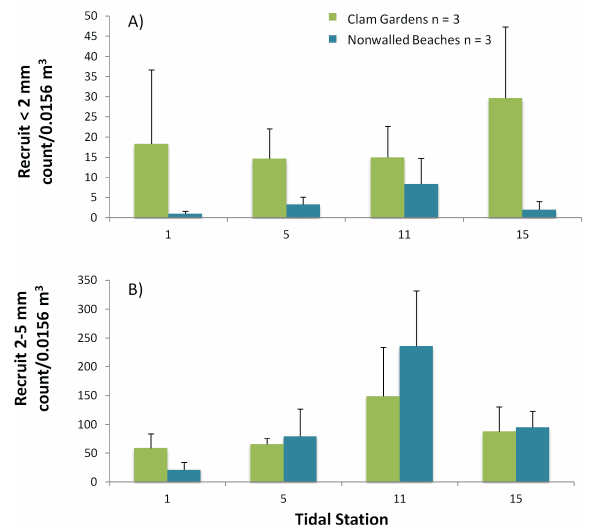
Fig. 8 . Density (0.0156 m³ ± SE) of bivalve recruits (A) < 2 mm in length and (B) 2-5 mm in length in clam gardens (n = 3) and nonwalled beaches (n = 3) at tidal stations 1, 5, 11, and